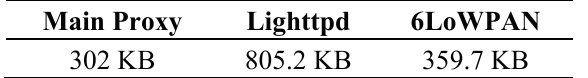
Table 2. ROM occupation of the CoAP proxy. Three modules compose the proxy.